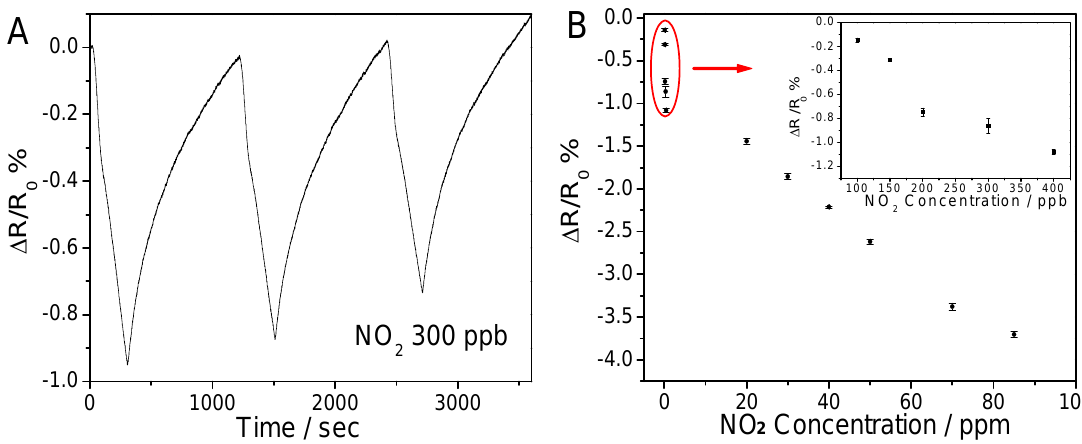
Figure 6. (A) Typical response of TiO of 10 ppm NH